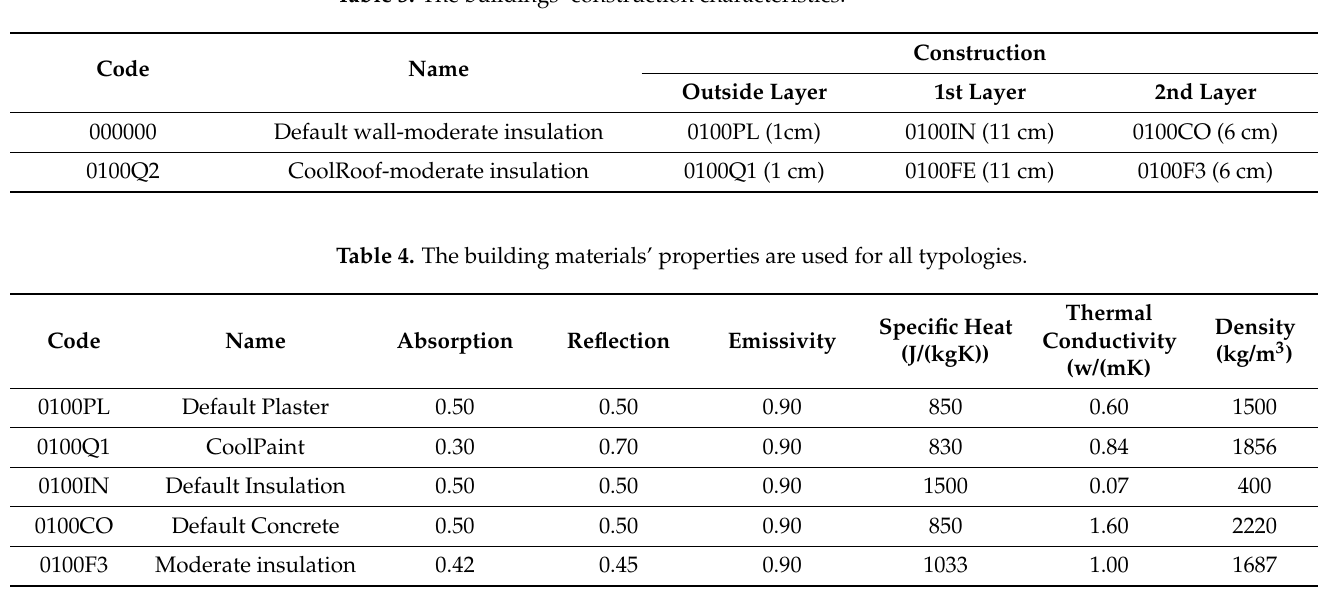
Table 3. The buildings’ construction characteristics.